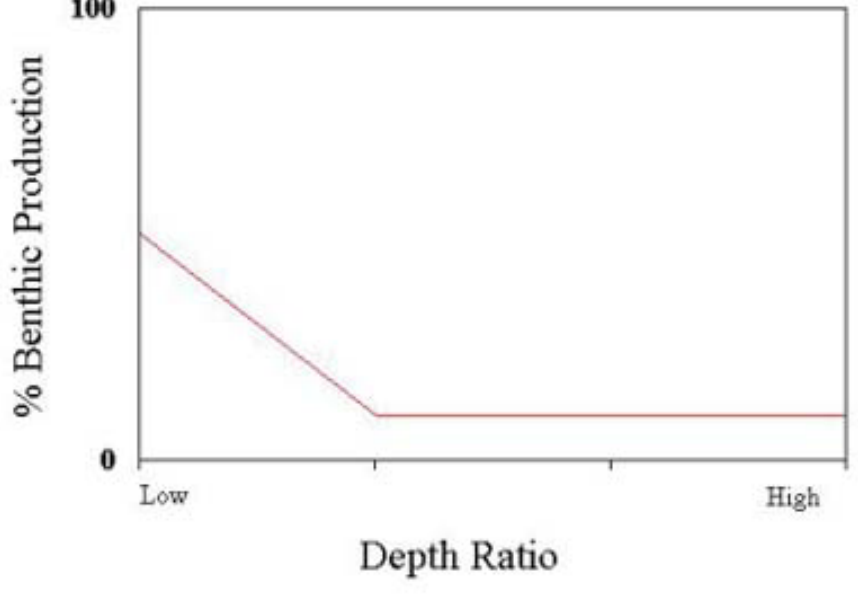
FIGURE 2. Conceptual relationship between lake morphometry (depth ratio, defined as mean depth/maximum depth) and the relative contribution of benthic primary production. See text for additional details.